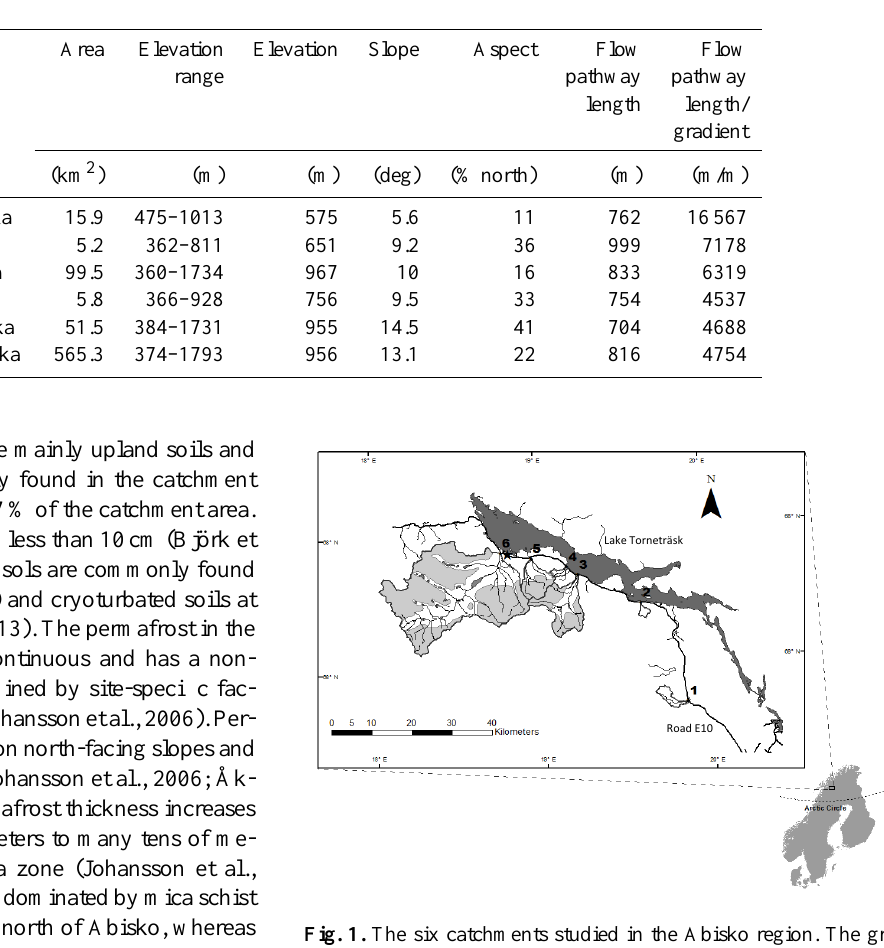
Table 1. Terrain characteristics for the six catchments considered in this study. The elevation, slope, and aspect are the mean for the whole catchment. Flow pathway length is defined as the distance from any given point in the catchment to the outlet of the catchment following the flow pathway defined by the steepest (topographic) gradient.